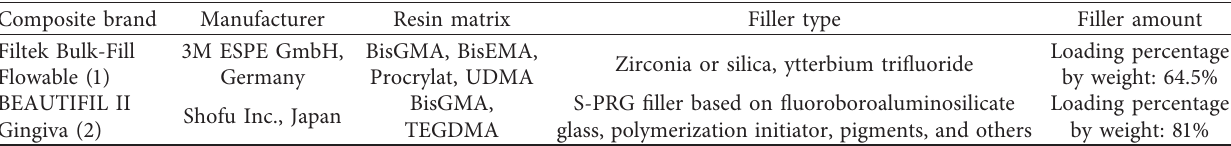
Table 1: The properties of the used composites.